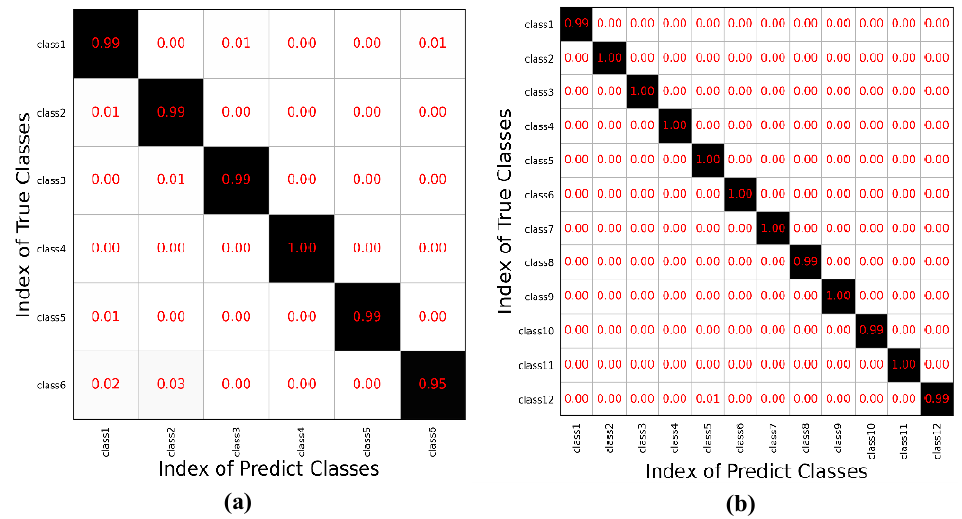
Figure 5. Confusion matrix of MAFN. ( a ) Result on dataset 1. ( b ) Result on dataset 2. The column of the matrix represents the predicted class of samples, while the row represents the true class of samples. The numbers in the non diagonal element represent the incorrect recognition ratio. The numbers in the black background along the diagonal represent the correct recognition ratio of each class.